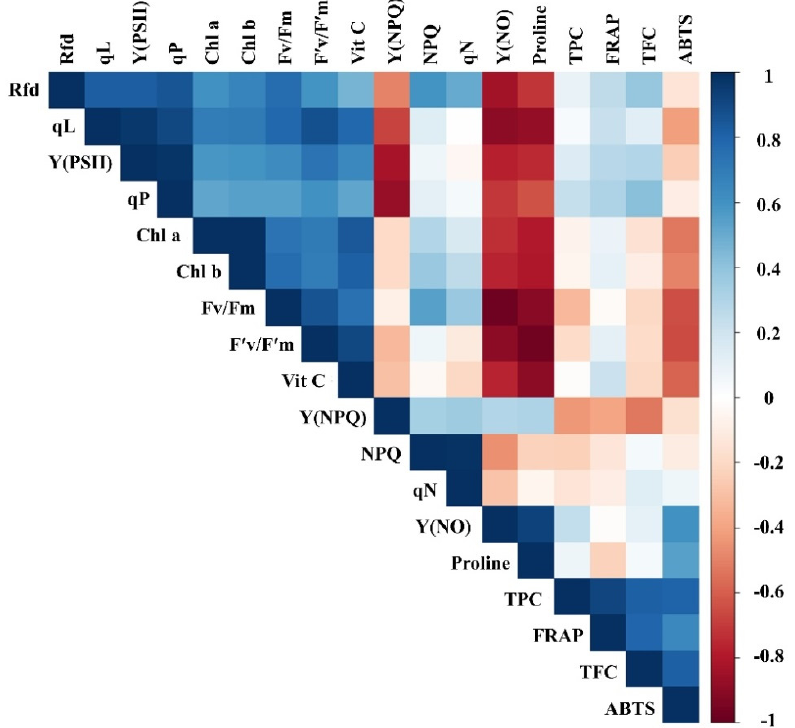
Figure 6. Correlation analysis for chlorophyll fluorescence parameters, phytochemicals, and antioxi- dant activities in lettuce seedlings, regardless of treatment length or drought stress. Blue and red boxes represent positive and negative correlation, respectively. Color intensities are proportional to the correlation coefficients, as shown in the legend to the right. Chl: chlorophyll, TPC: total phenol content, TFC: total flavonoid content, FRAP: ferric-reducing antioxidant power; ABTS: 2,2 ′ -azino- bis (3-ethylbenzothiazoline-6-sulfonic acid). Refer to Table 1 for detailed information on CF param- eters. (r = 0.868***), qL (r = 0.788**), and Rfd (r = 0.761*), and negatively correlated with